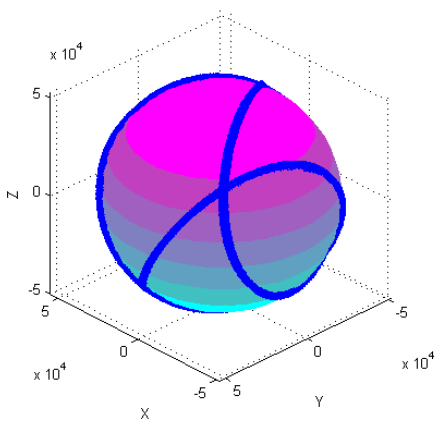
Figure 6. Optimal ellipsoid fitting (EF3) Figure 7. Optimal ellipsoid fitting (EF4).